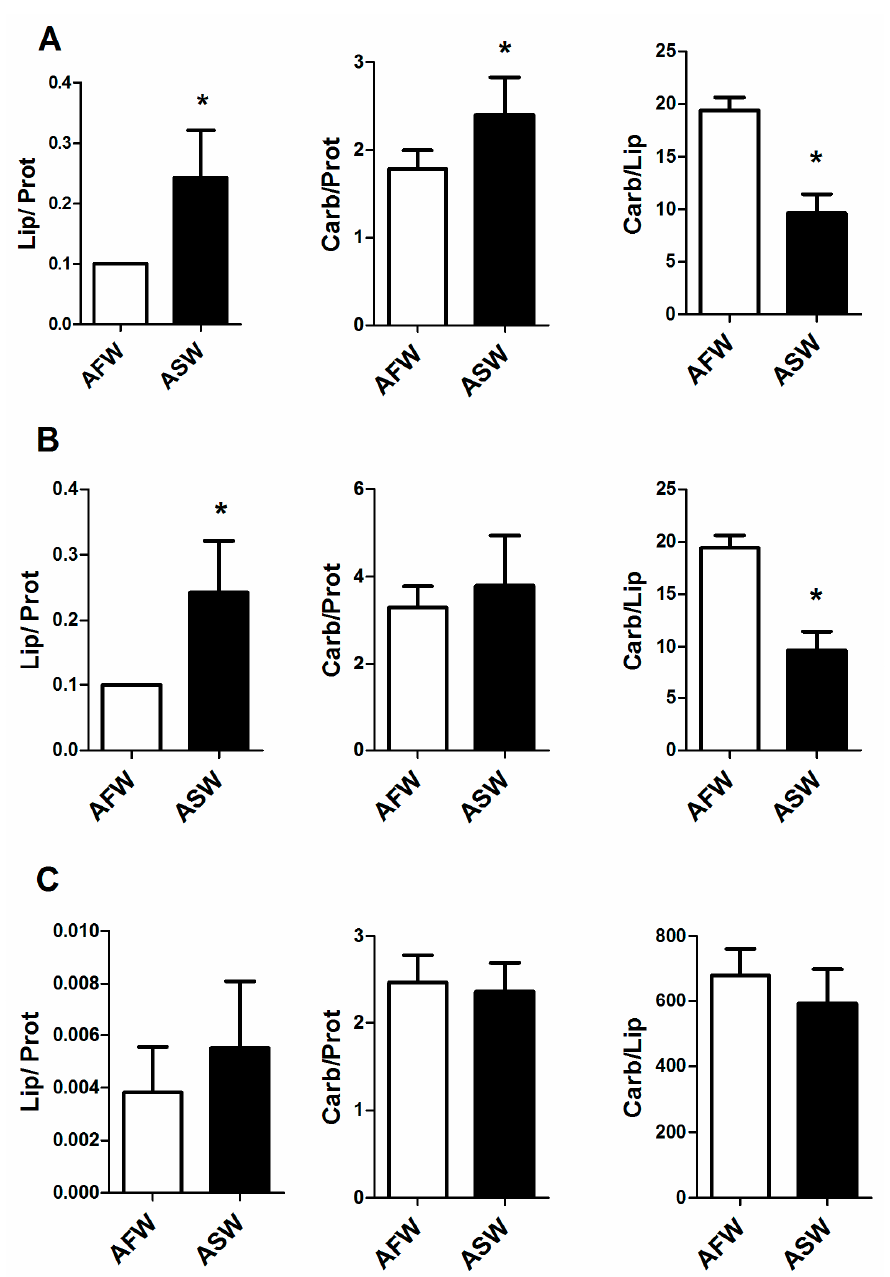
Figure 4. Lipid to protein, carbohydrate to protein and carbohydrate to lipid ratio in leaf ( A ); taproot ( B ) and lateral root ( C ) of B. vulgaris cultivated in AFW and ASW. Statistical significance is labelled with asterisks ( p < 0.05), bars indicate SD.